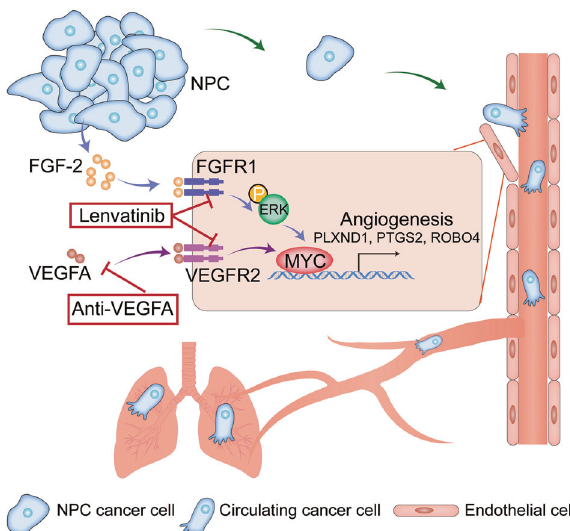
Fig. 7 Lenvatinib insigni fi cantly affects the immune microenvironment in NPC in humanized NSG mice. A Schematic diagram of the establishment of humanized NSG mice. B Representative FACS analysis of human CD45 + cells in mouse peripheral blood. Human CD45 + cell percentage greater than 25% was considered successful in modeling. C – E Tumor growth ( C ), tumor weights ( D ) were measured in vehicle-, anti-VEGF-, and lenvatinib-treated NPC tumors. The tumor inhibition ratio were calculated ( E ) ( n = 3 samples per group). F Representative micrographs of Ki67 + proliferative cells and cleaved caspase-3 + apoptotic cells in vehicle-, anti-VEGF-, and lenvatinib-treated NPC tumors. Scale bar = 50 μ m. Quanti fi cation of Ki67 + , cleaved caspase-3 + signals, and PA index in vehicle-, anti-VEGF-, and lenvatinib-treated NPC tumors. ( n = 8 random fi elds per group) G Representative micrographs of CD31 + microvessels and CA9 + hypoxic areas in vehicle-, anti-VEGF-, and lenvatinib-treated NPC tumors. Scale bar in upper panel = 100 μ m, scale bar in lower panel = 50 μ m. Quanti fi cation of CD31 + tumor vessel parameters and CA9 + signals in vehicle-, anti-VEGF-, and lenvatinib-treated NPC tumors ( n = 8 random fi elds per group). H Quanti fi cation of hCD45 + hCD14 + population, hCD45 + hCD19 + population, hCD45 + hCD3 + population, and hCD45 + hCD56 + population in the NPC TME ( n = 3 samples per group). I Quanti fi cation of mCD45 + mCD11b + mF4/80 + population, mCD45 + mB220 + population, mCD45 + mCD3 + population, and mCD45 + mCD49b + population in the NPC TME ( n = 3 samples per group). ** P < 0.01; *** P < 0.001. NS not signi fi cant. Data presented as mean ± SD.